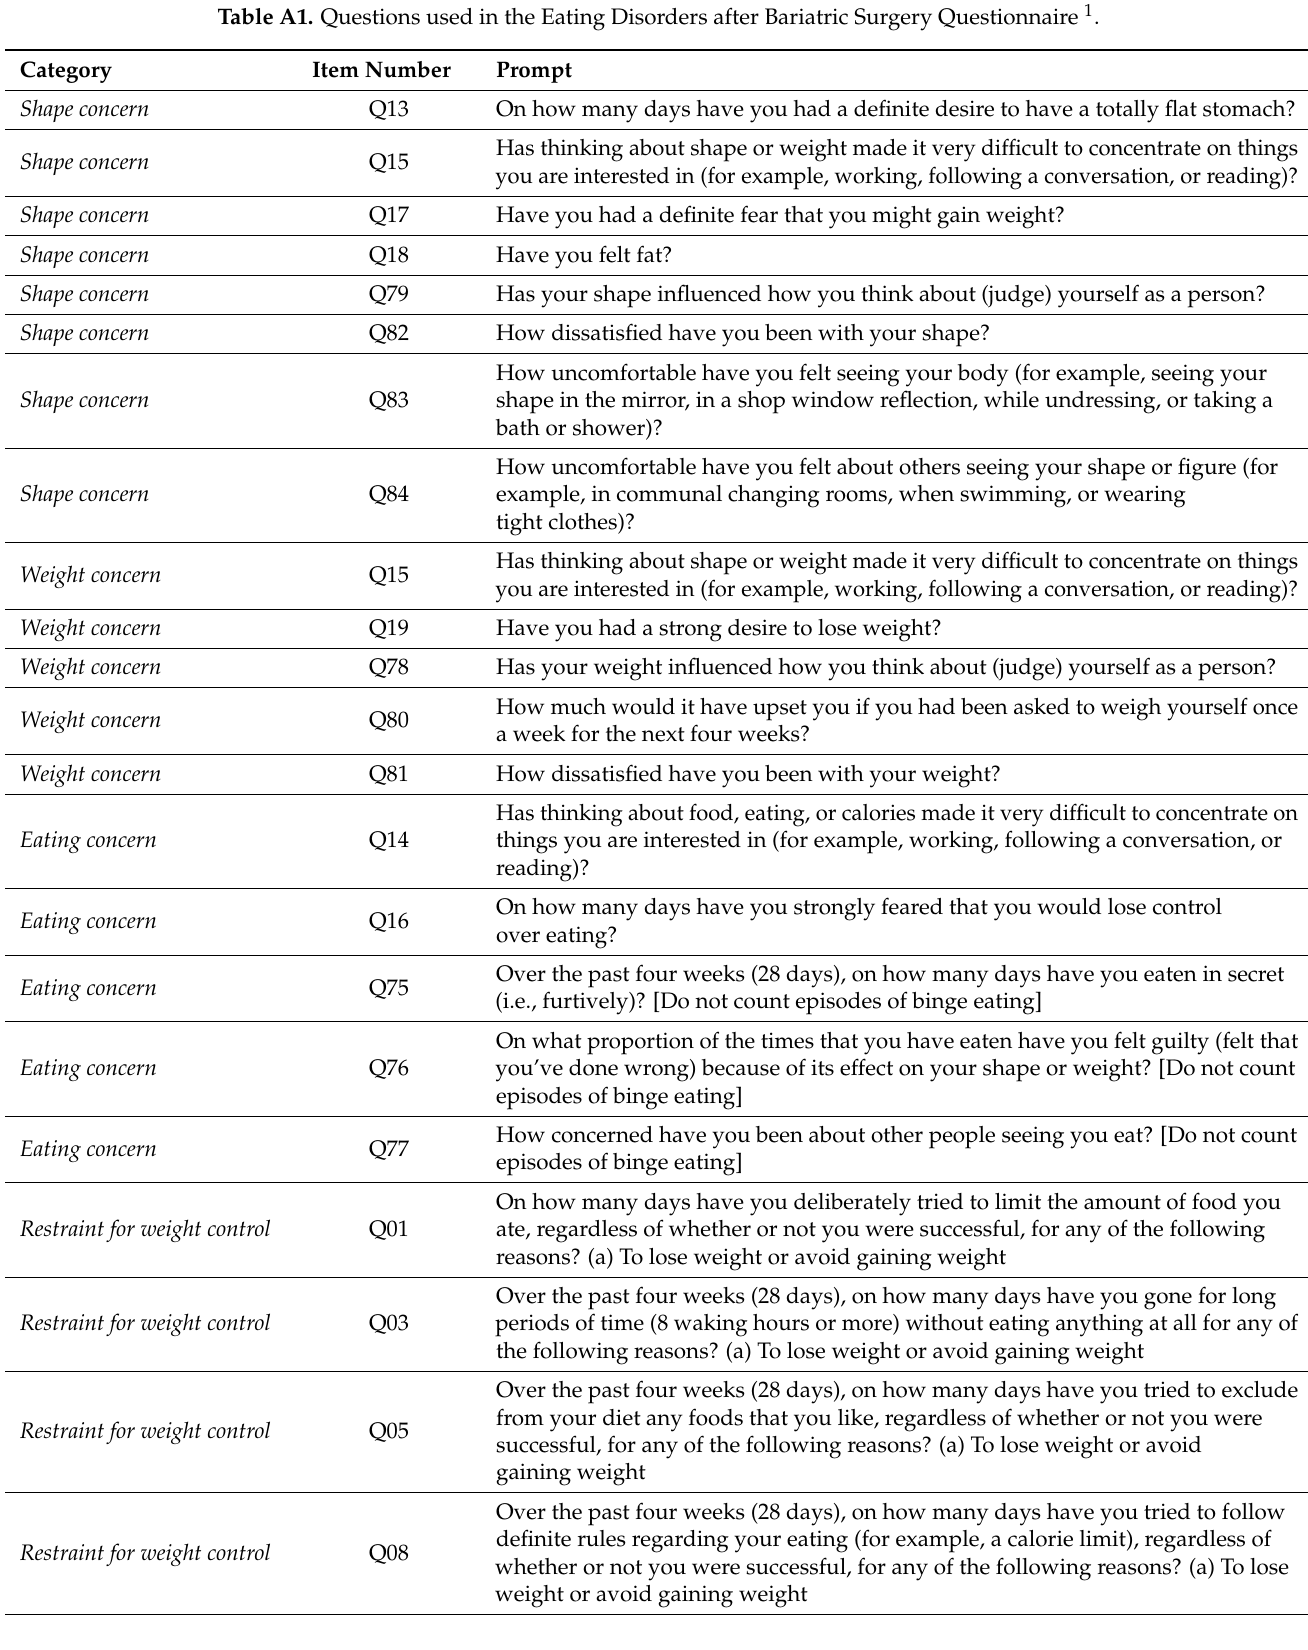
Table A1. Questions used in the Eating Disorders after Bariatric Surgery Questionnaire 1